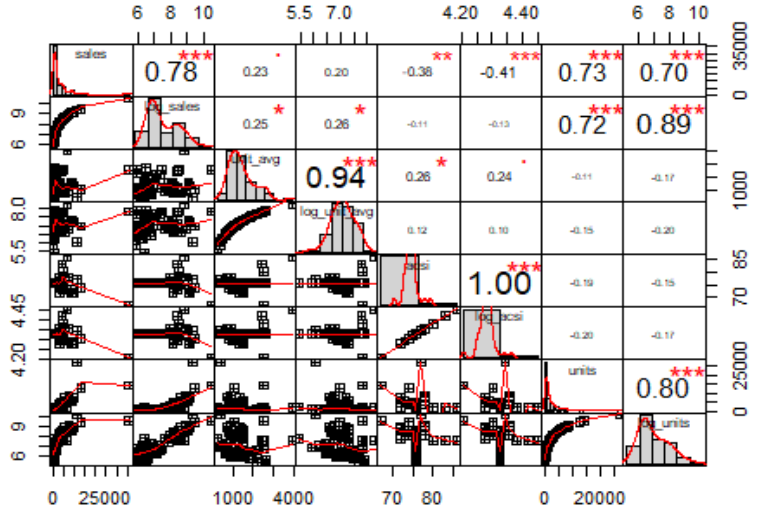
Fig. 7. Scatterplots, histograms, and correlations Table 6. QSR Mean Values by Segment: Sales ($